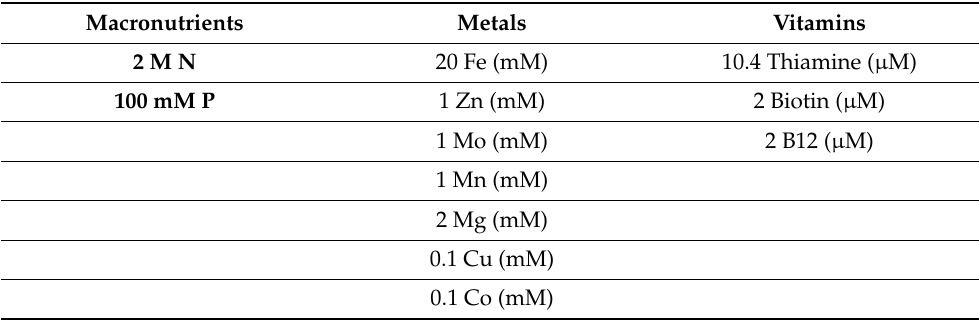
Table 1. Elemental composition of the culture medium Nutribloom plus. Macronutrients